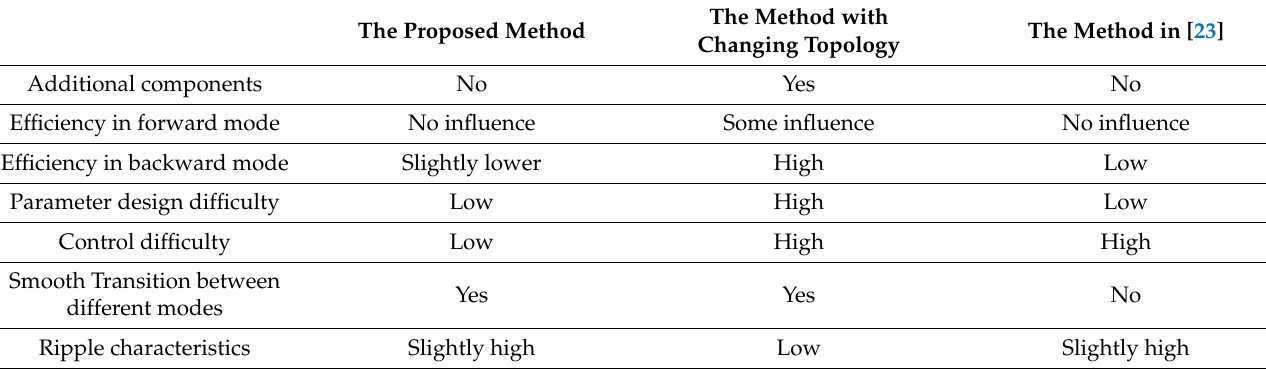
Table 2. The comparison between the proposed method and other